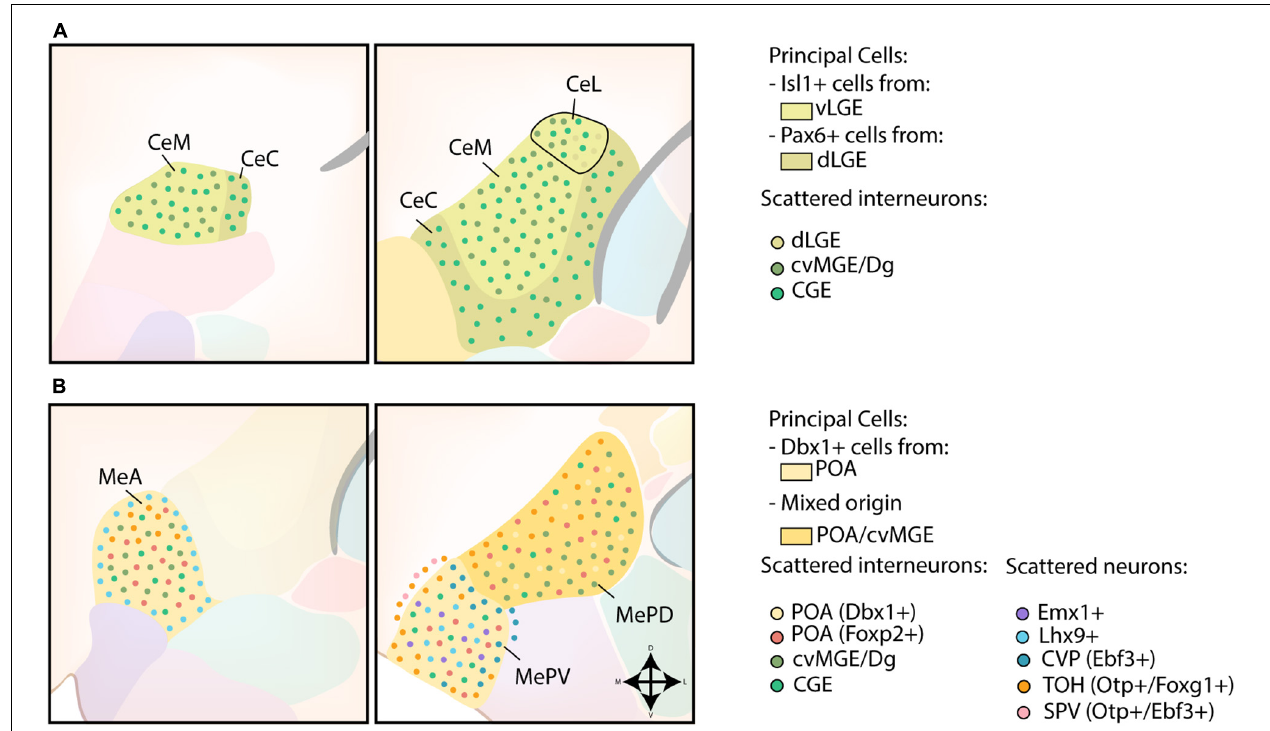
FIGURE 4 | Developmental origin of the centromedial amygdala. (A) Schematic overview of the neuronal origin of cells within the central amygdala (CA). Isl1-lineage cells from the ventral LGE (vLGE) inhabit the medial CA (CeM) and the centromedial part of the lateral CA (CeL), while Pax6-expressing cells from the dorsal LGE (dLGE) inhabit the capsular CA (CeC), with the exception of its ventromedial part, and the lateral part of the CeL. Presumptive CGE-derived interneurons can be found throughout the entire CA. Interneurons from the cvMGE instead prefer the CeM and CeL, and seem to avoid the CeC. (B) Schematic overview of the neuronal origin of cells within the medial amygdala (MA). POA-derived Dbx1-expressing neurons are spread throughout the entire medial amygdala (MA), but preferentially localize to the anterior MA (MeA) and posteroventral MA (MePV). They are complemented throughout the MA by Foxp2-expressing cells from the POA. Lhx9-expressing neurons, originating in the anterior amygdalar unit, populate a ring-shape surrounding the MeA and the core region of the MePV. Some Emx1-expressing cells were also identified in the MePV. Within the MePV, cells from the caudoventral pallium (CVP) and telencephalon-opto-hypothalamic domain (TOH) occupy specific niches. While cells from the TOH preferentially inhabit the medial side of an imaginary shell surrounding the MePV, cells from the CVP preferentially occupy the dorsolateral edge of the MePV. The TOH-derived cells are also present in the superficial layer of the MA, together with Otp+/Ebf3+ cells from other domains of the supraopto-paraventricular hypothalamus (SPV). TOH-derived neurons are also present within the posterodorsal MA (MePD), where they prefer to inhabit its medial part. A population of CGE-derived interneurons is presumed to populate the MA. In addition, small interneurons from the cvMGE/Dg are scattered within the MeA and the